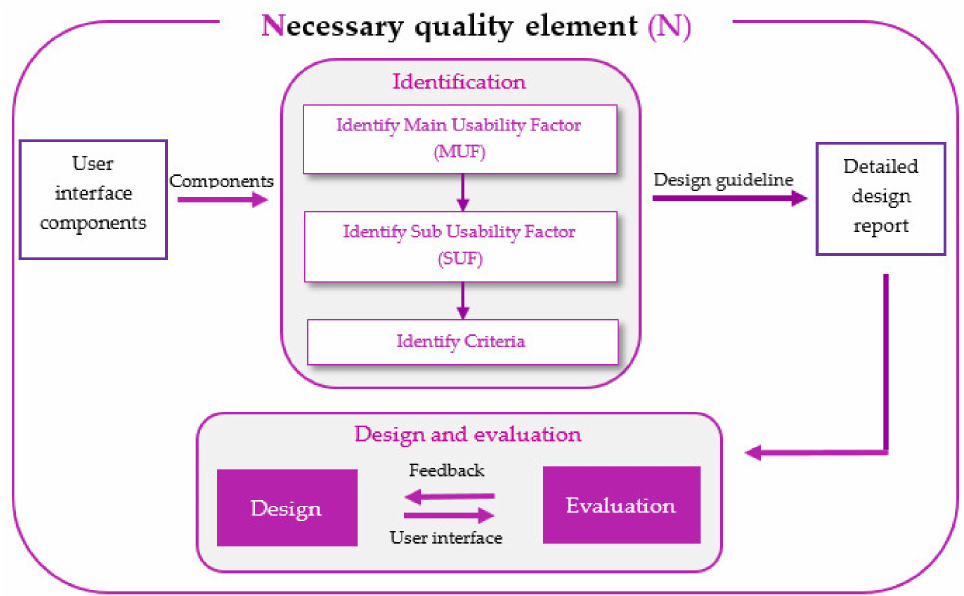
Figure 4. The Necessary (N) quality element identification